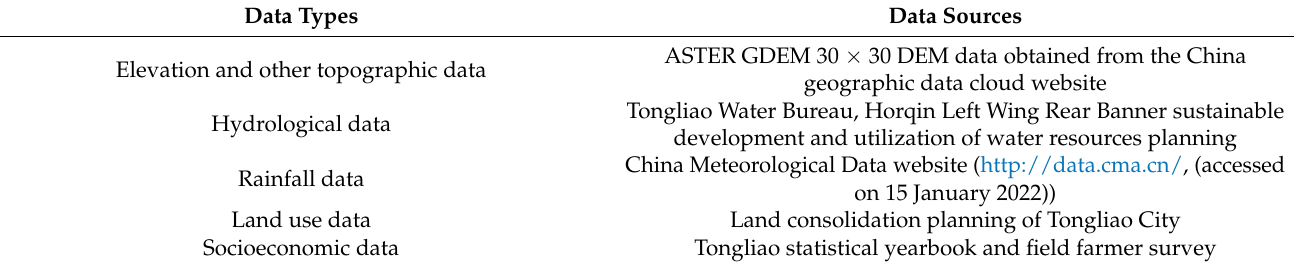
Table 1. Data types and sources.